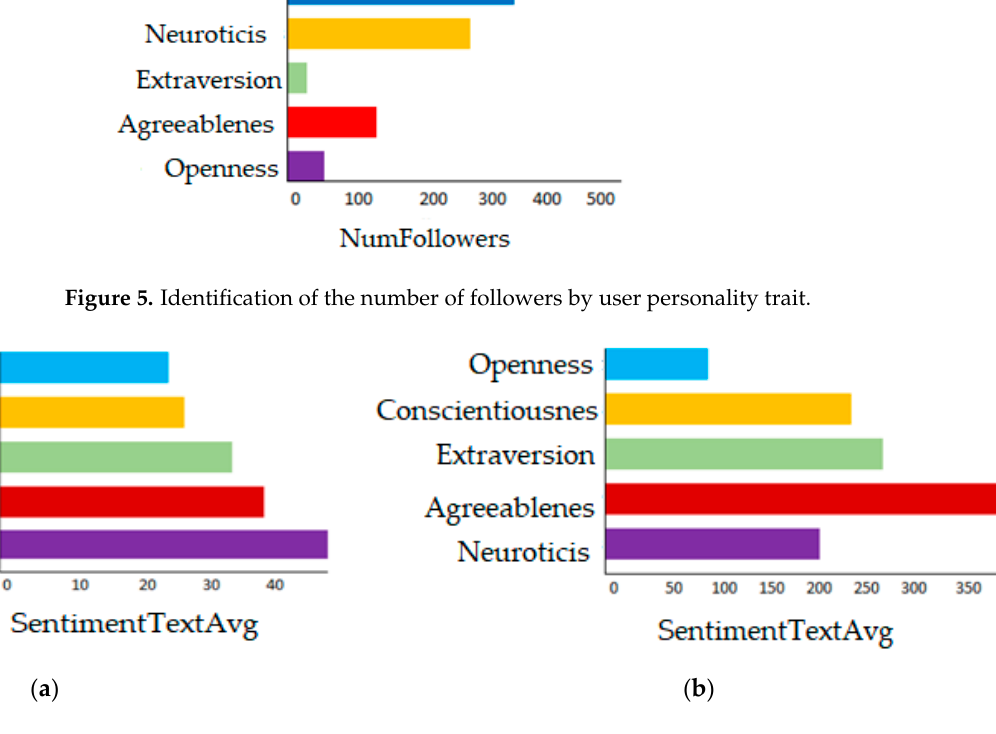
Figure 6. Analysis of relevant sentiments of predominant personalities: ( a ) negative sentiments of tweets by predominant personality; ( b ) the positive sentiment of tweets by predominant personality.